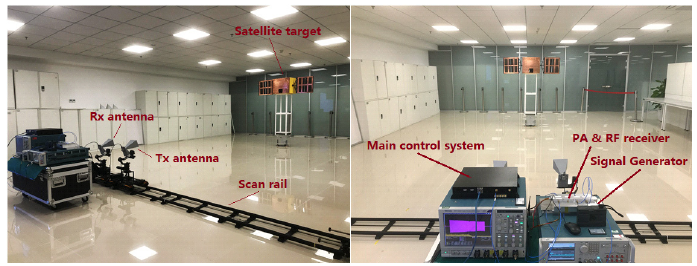
Figure 8. Imaging scene of the satellite target. Table 5. Experimental parameters of the proposed non-uniform hybrid sampling technology.